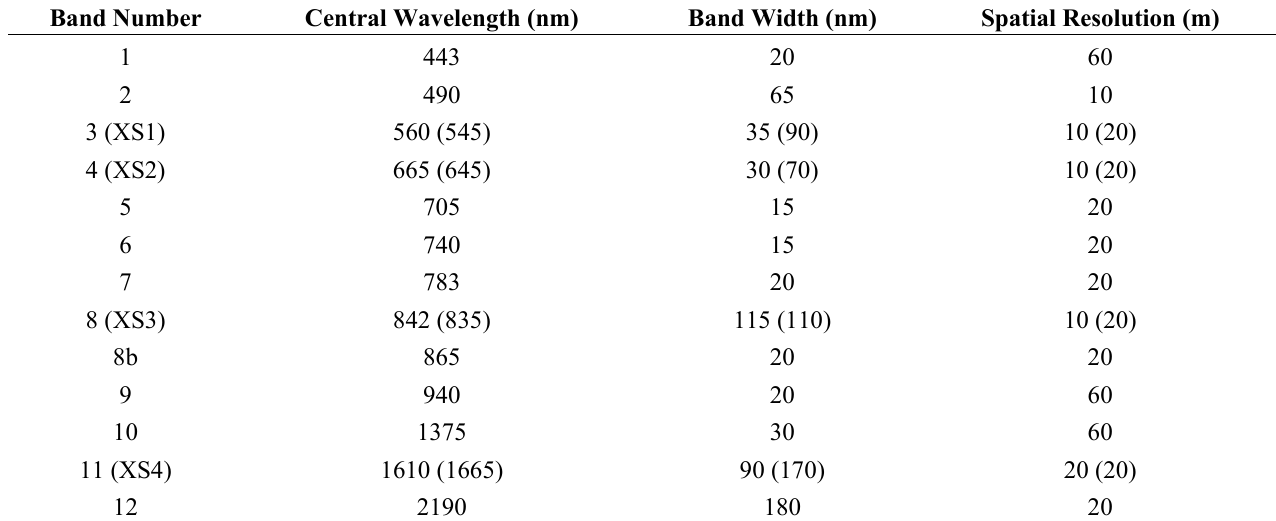
Table 1. Sentinel-2 spectral bands and spatial resolution. Corresponding information for SPOT4 are indicated in